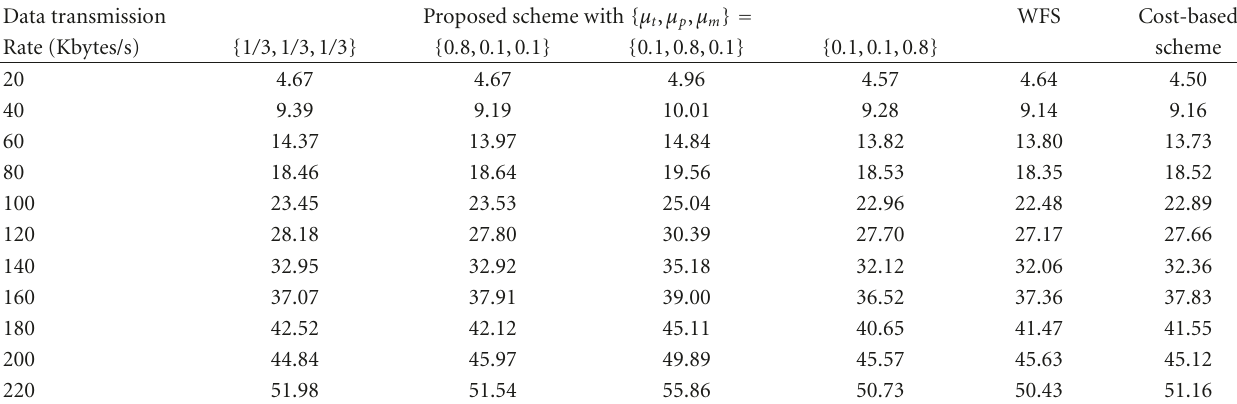
Table 5: Data transmission rate (Kbyte/s) versus throughput when the UDP tra ffi c ( ρ = 0) is